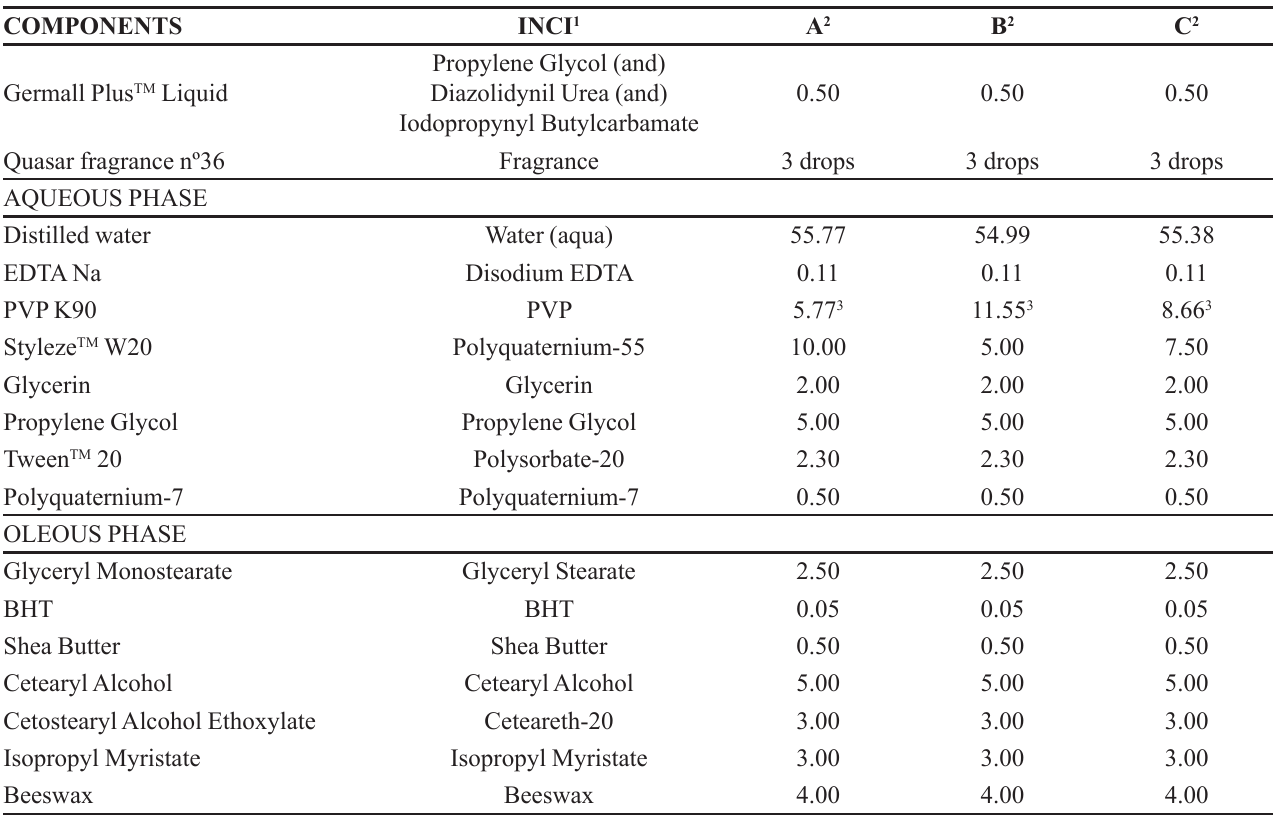
TABLE I - Composition of the fixing masks A, B and C adapted from (Corrêa et al. , 2005; Brandão, 2009; Correa, 2012)